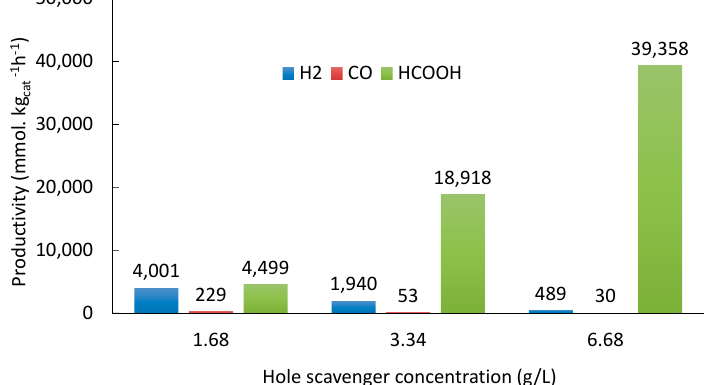
Figure 7. Effect of HS concentration on productivity. Reaction time: 24 h. P25 as a photocatalyst (0.031 g L − 1 ) and at pH = 13/14.